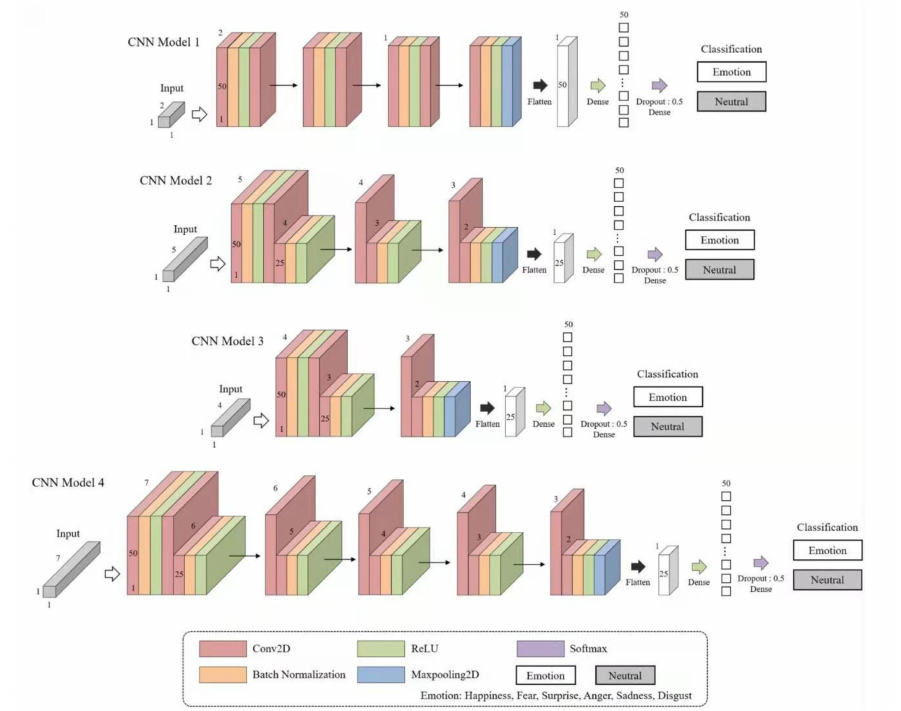
Figure 8. CNN Models 1–4, which were constructed di ff erently according to input data.